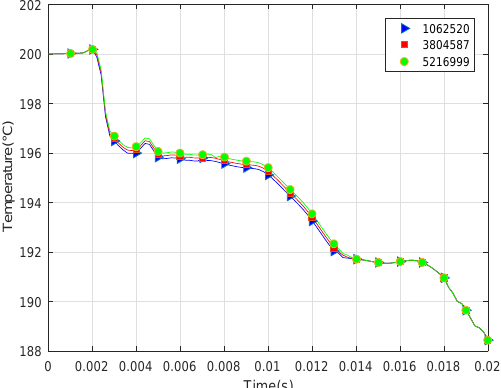
Figure 5. Mesh independency check (temperature of observation point in